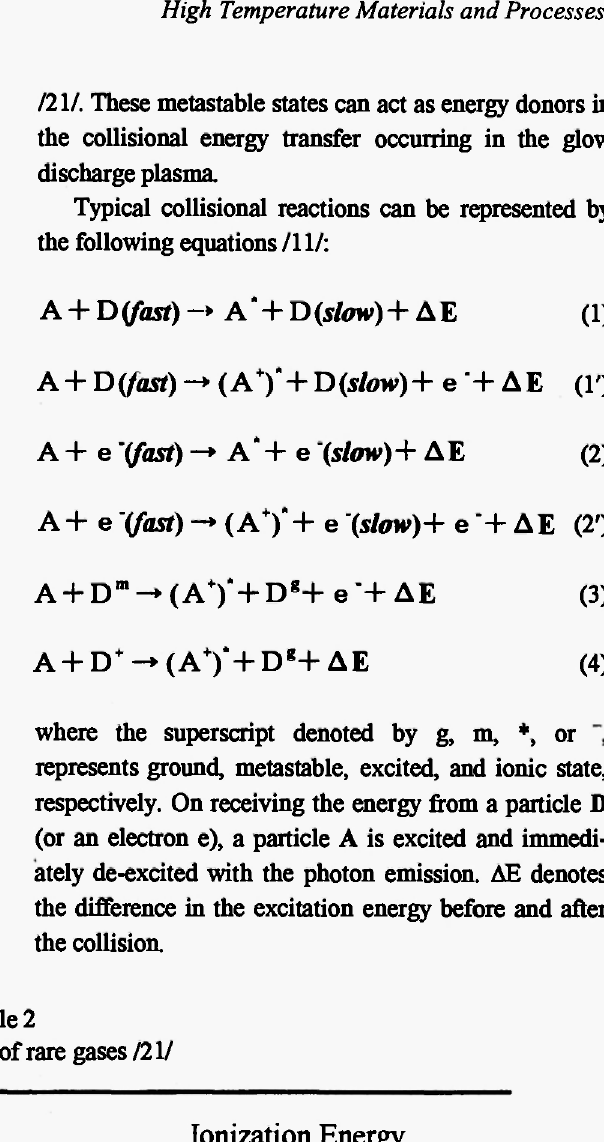
Metastable levels of rare gases